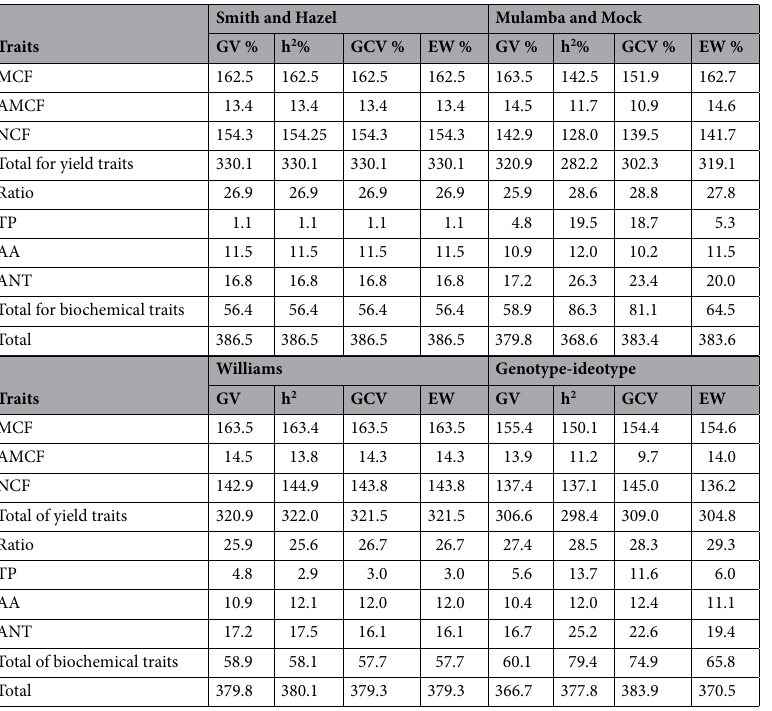
Table 3. Estimates of percentage gains obtained by simultaneous selection with application of four indices based on four criteria of economic weights for seven traits evaluated in 10 populations of Fragaria × ananassa Dusch. MCF mass of commercial fruits (g plant −1 ), AMCF average mass of commercial fruits (g fruit −1 ), NCF number of commercial fruits (fruits plant −1 ), Ratio, soluble solids (Brix°)/titratable acidity (g citric acid 100 g −1 pulp); TP total pectin (g total pectin 100 g −1 pulp), AA ascorbic acid (mg ascorbic acid 100 g −1 pulp), and ANT anthocyanins (mg cyanidin-3-glucoside 100 g −1 pulp). GV genotypic variance, h 2 herdability, GCV